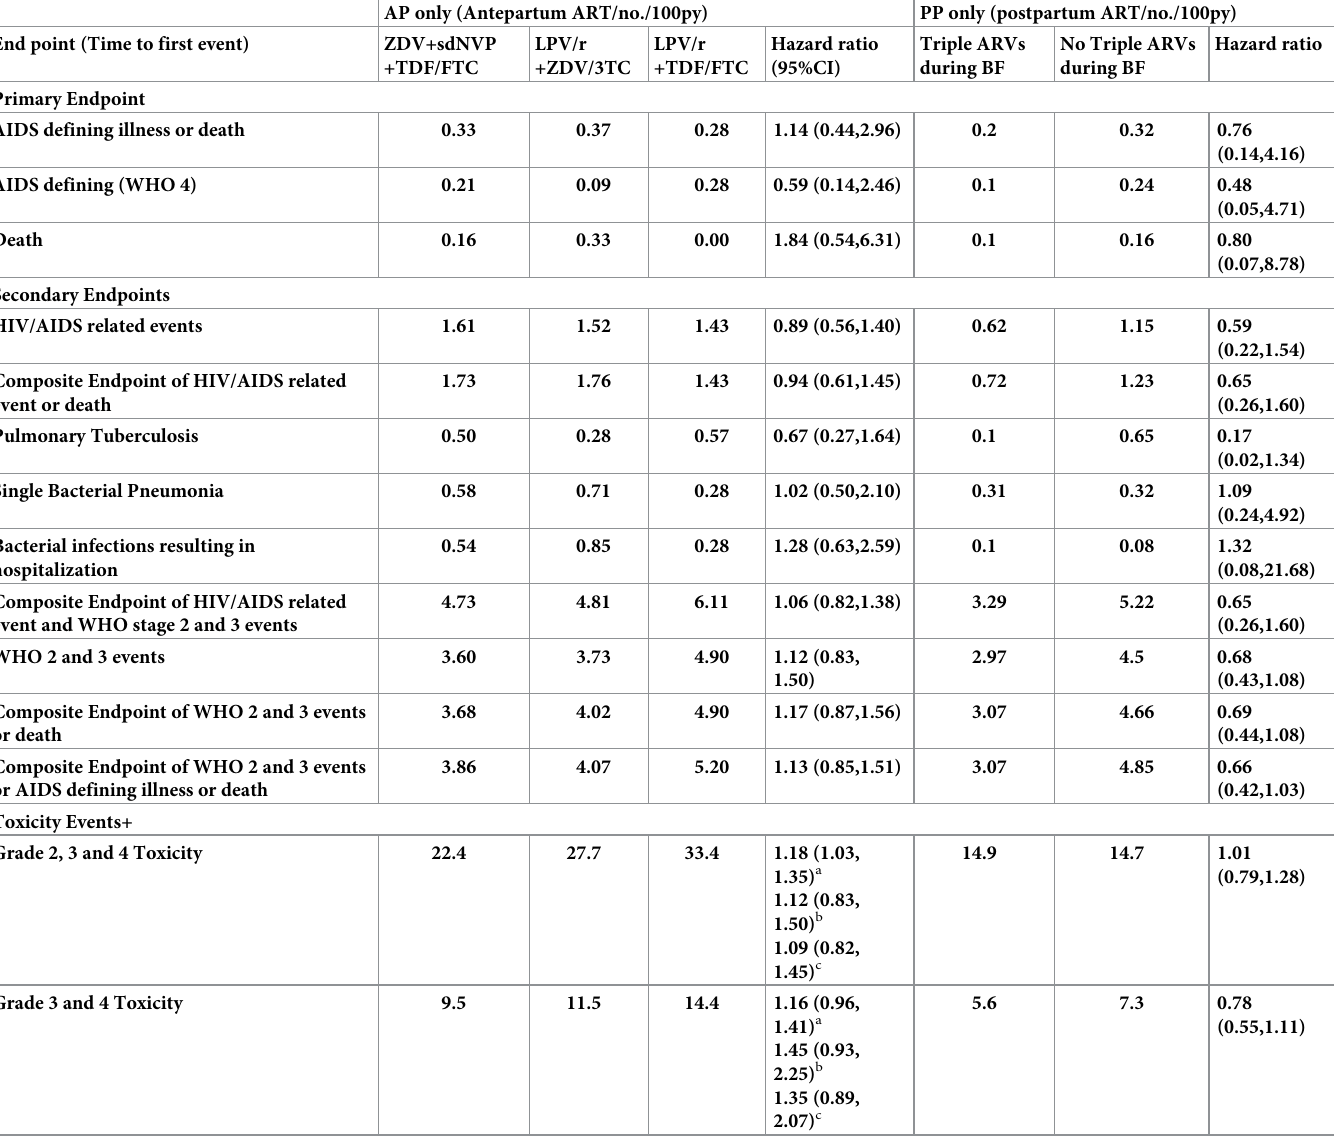
Table 2. Summary for the primary, secondary clinical endpoints for AP-only and PP-only. AP only (Antepartum ART/no./100py) PP only (postpartum